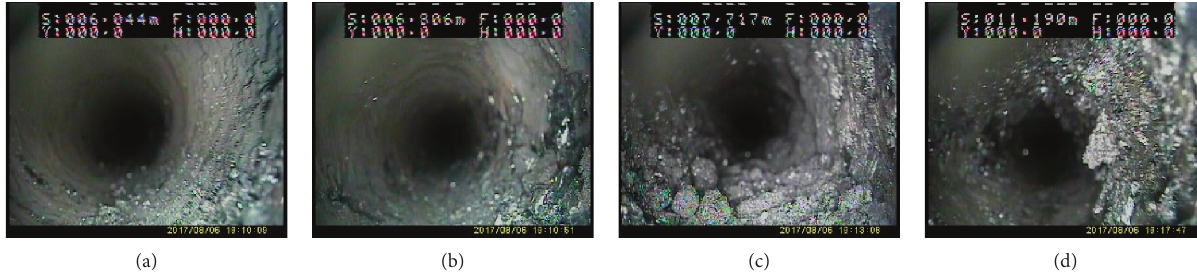
Figure 14: The distribution of the surrounding rock (2.3–7.8m) outside the anchor zone. (a) 2.6m. (b) 4.2m. (c) 5.8m. (d) 7.6